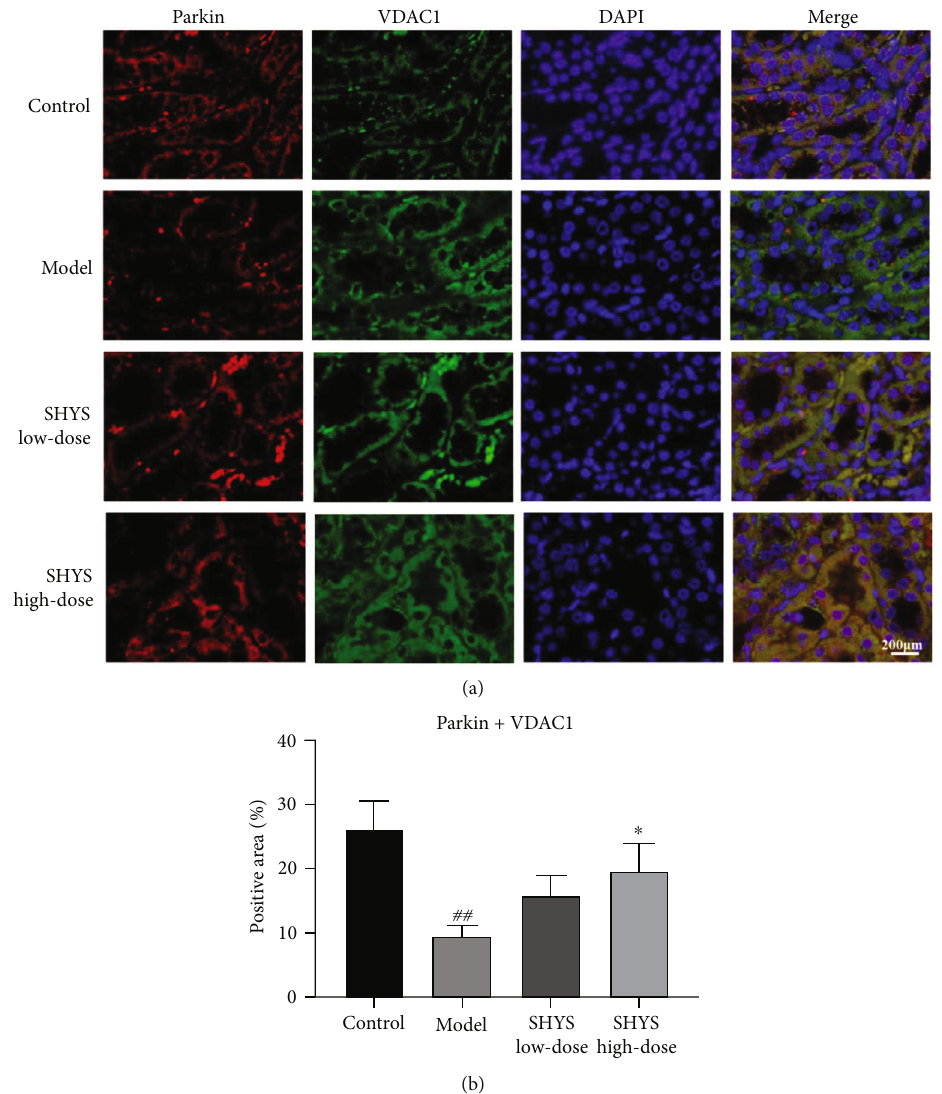
Figure 4: SHYS treatment increased the coexpression of Parkin and VDAC1 in DKD model rats. The coexpression of Parkin and VDAC1 in the kidney was investigated using immuno fl ourescence. (a) The mange of immuno fl ourescence staining in each group ( 400 × ). (b) Quantitative of immuno fl ourescence based on positive